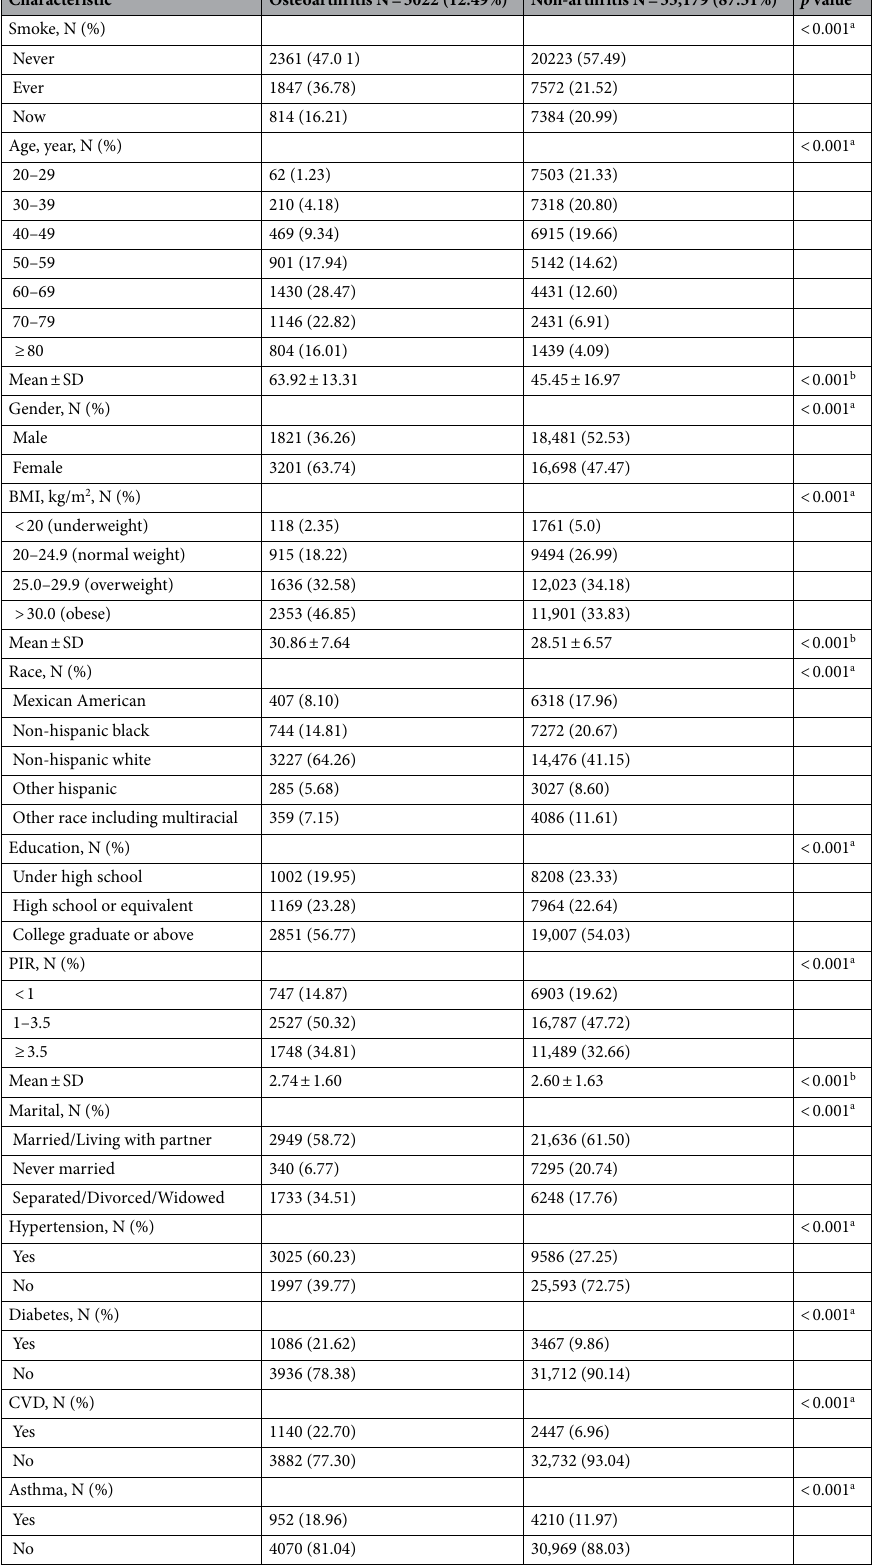
Table 1. Demographics and characteristics of study participants from NHANES 1999–2018. a means Chi- square test, b means Student’s